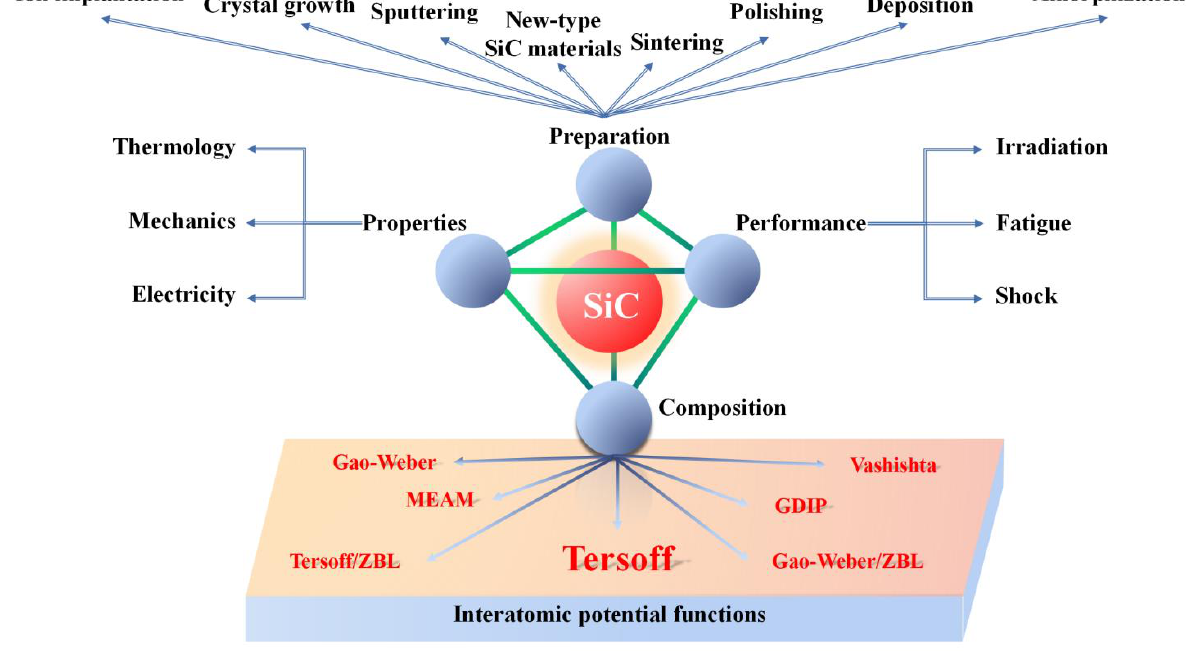
Figure 16. The brief summary of MD simulation studies of SiC materials.